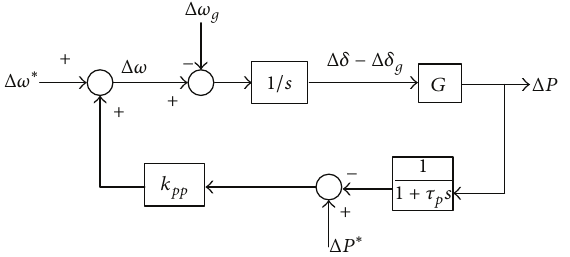
Figure 4: Small signal model of the conventional 𝑄 - 𝐸 droop